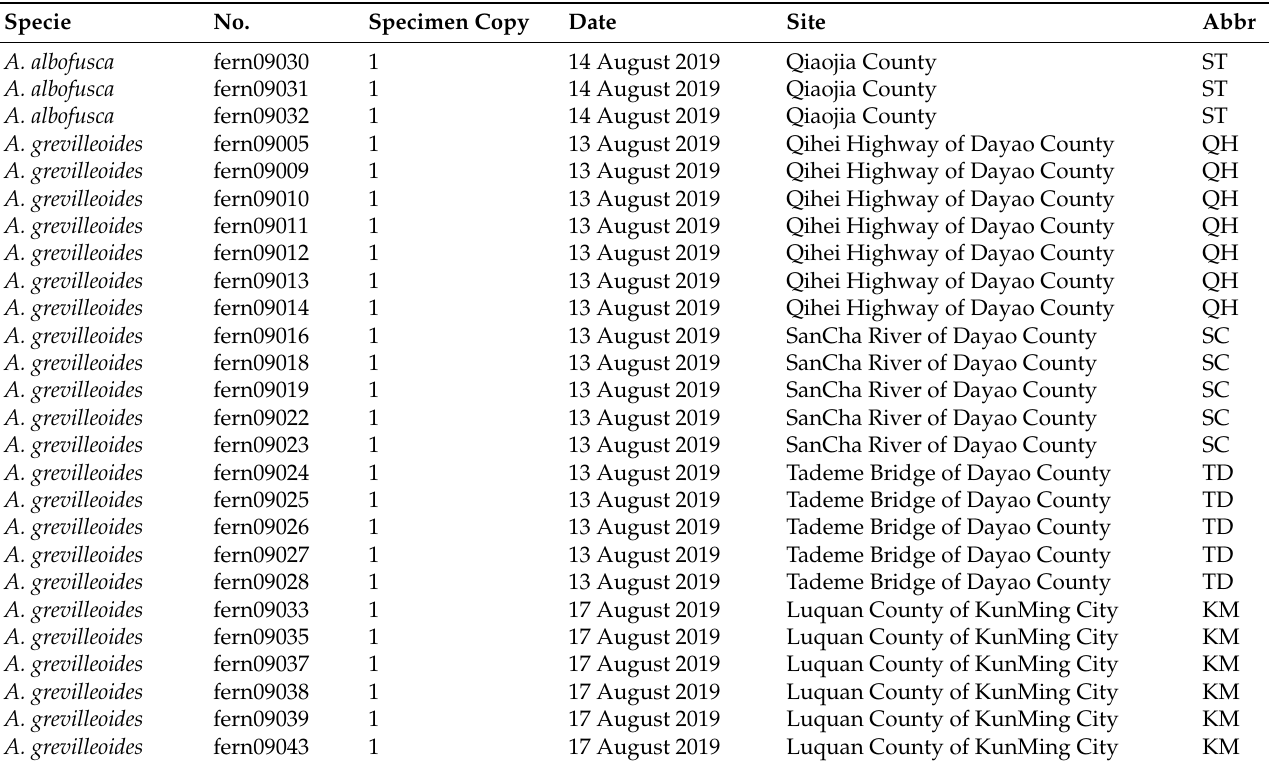
Figure 5. Spatial distribution points in the wild population of Aleuritopteris grevilleoides . Table 3. Sample details of Aleuritopteris